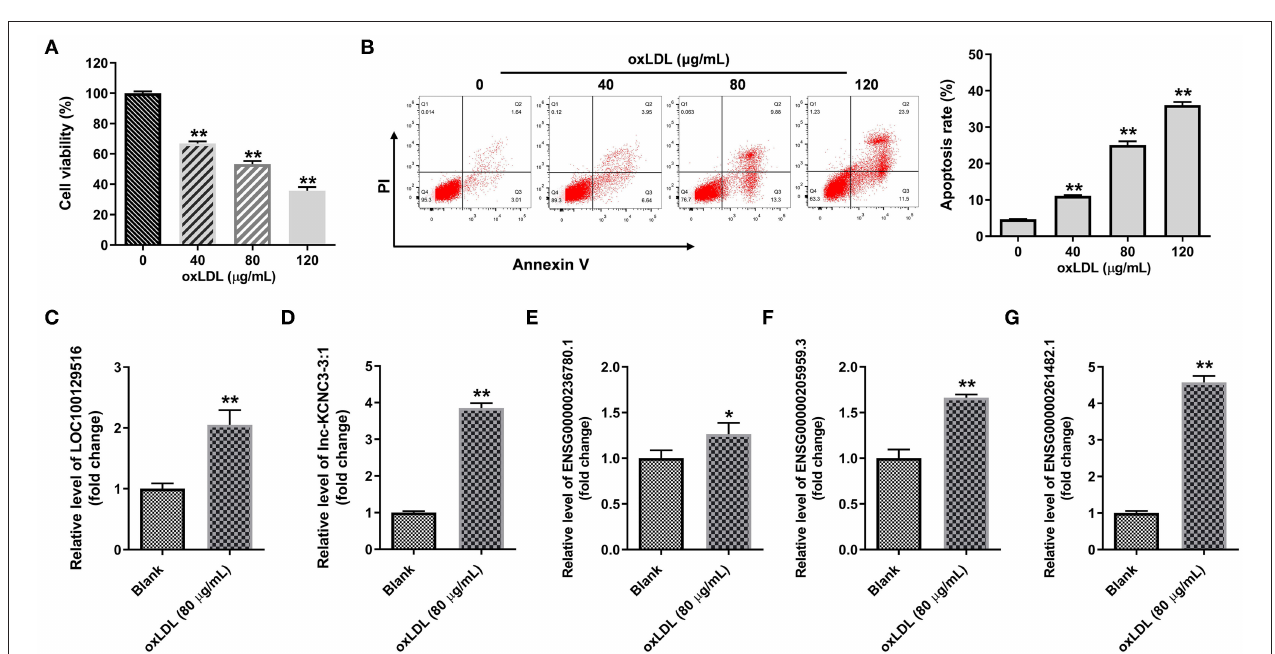
FIGURE 2 | OxLDL increased the expression of LOC100129516, lnc-KCNC3-3:1 and ENSG00000261482. (A) HUVEC cells were treated with different concentrations (0, 40, 80, and 120 µ g/mL) of oxLDL for 24h. CCK-8 assay was used to detect the viability of HUVEC cells. (B) Flow cytometer assay was used to analyze HUVEC cells apoptosis. (C–G) RT-qPCR was used to detect the expression levels of LOC100129516, lnc-KCNC3-3:1, ENSG00000236780.1, ENSG00000205959.3 and ENSG00000261482.1. * P < 0.05; ** P < 0.01 compared with control group, n = 3.